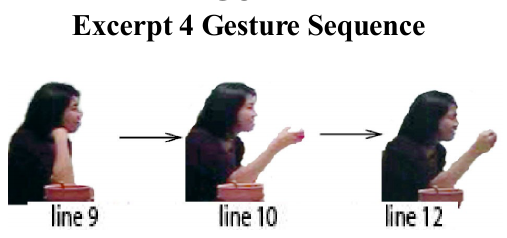
Excerpt 4 Gesture